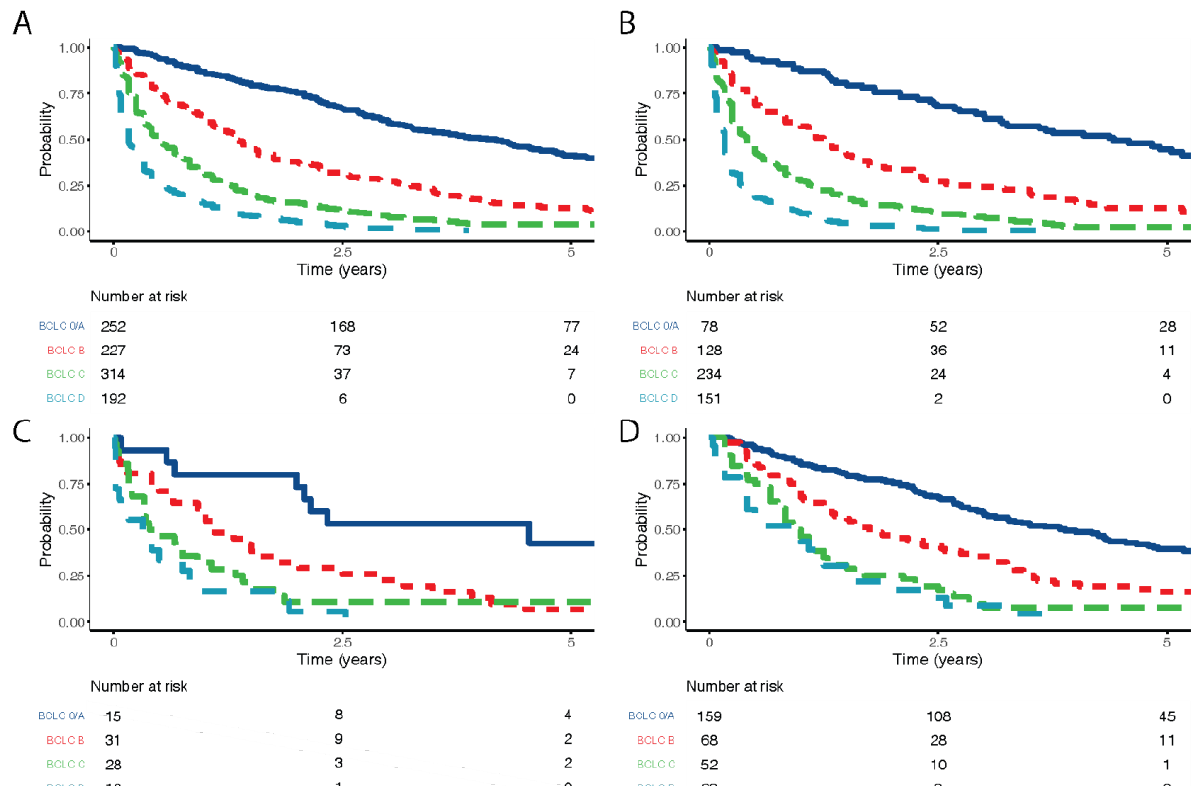
Figure 1. Overall survival by BCLC stage. ( A ) For all patients included in the study, ( B ) for patients never entered into